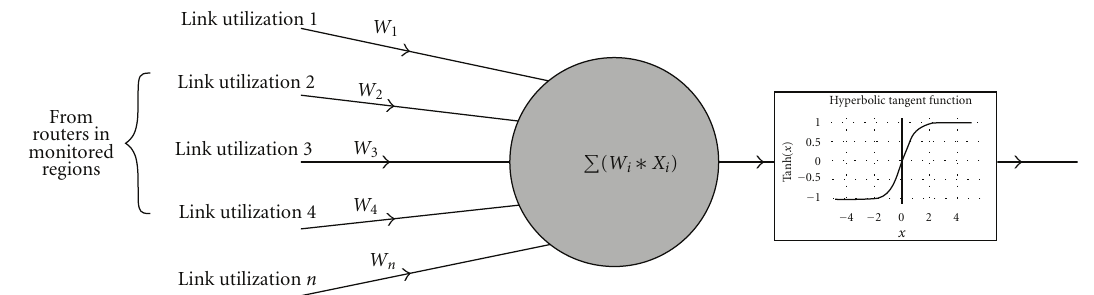
Figure 3: Neuron